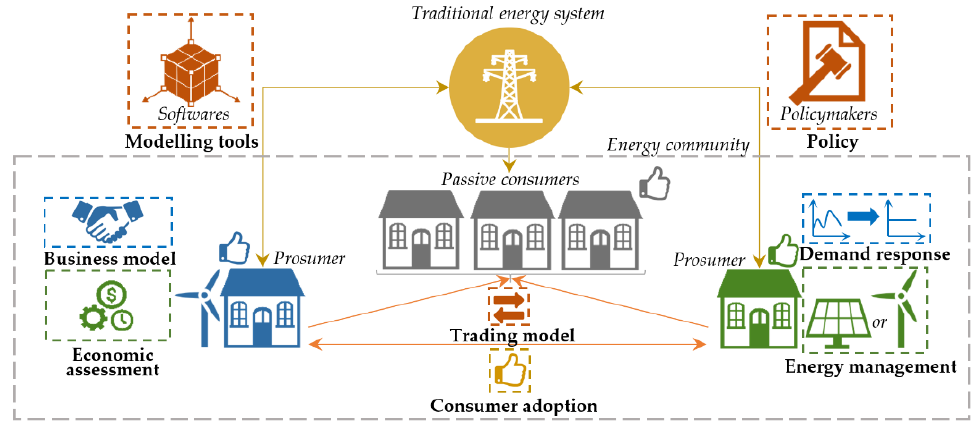
Figure 1. Representation of energy community and consumer interest aspects.